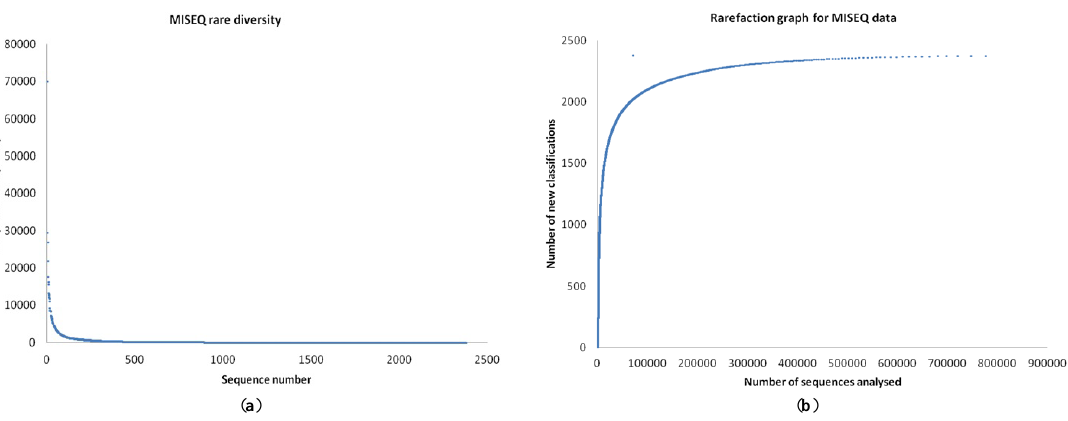
Figure 5. Pie chart representing the number of bacterial genera identified by MISEQ. Microorganisms 2015 , 3